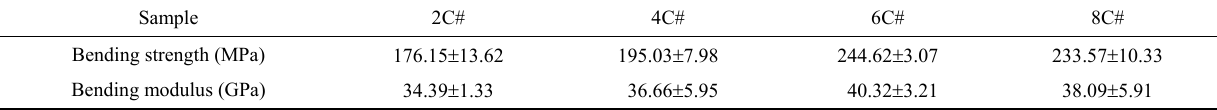
Table 7 Bending strengths of C pf /SiC composites prepared with different resin carbon contents